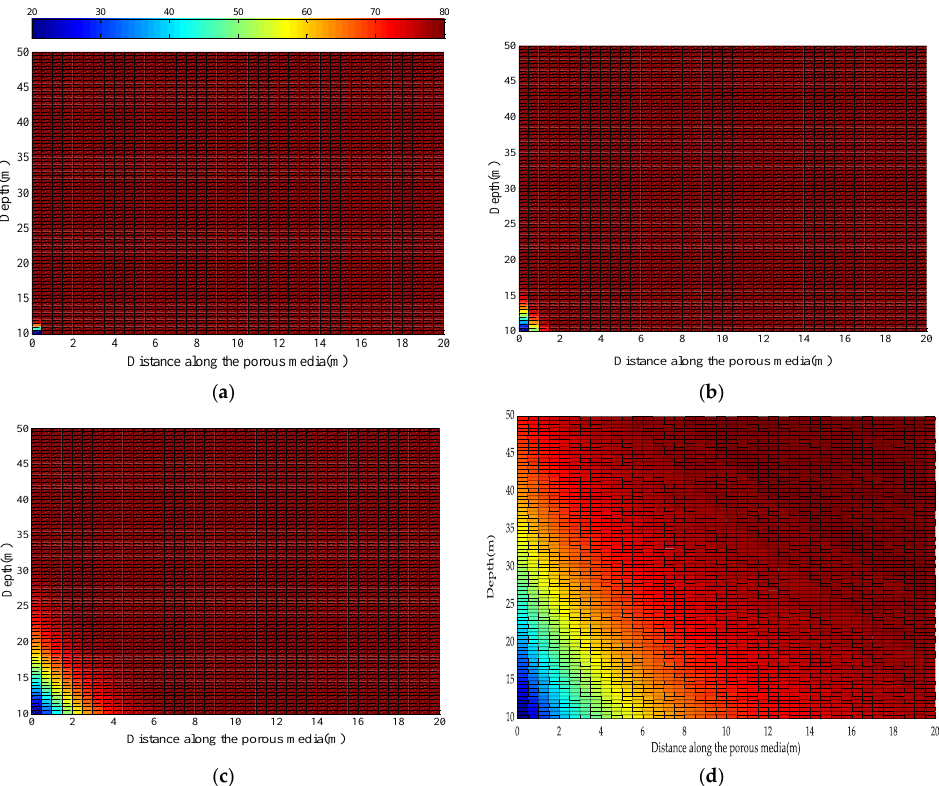
Figure 7. Temperature distribution in the overlying rock for the negligible conduction case for λ 1 = 1.2 W/m · K at ( a ) 10 days, ( b ) 100 days, ( c ) 1000 days and ( d ) 10,000 days.